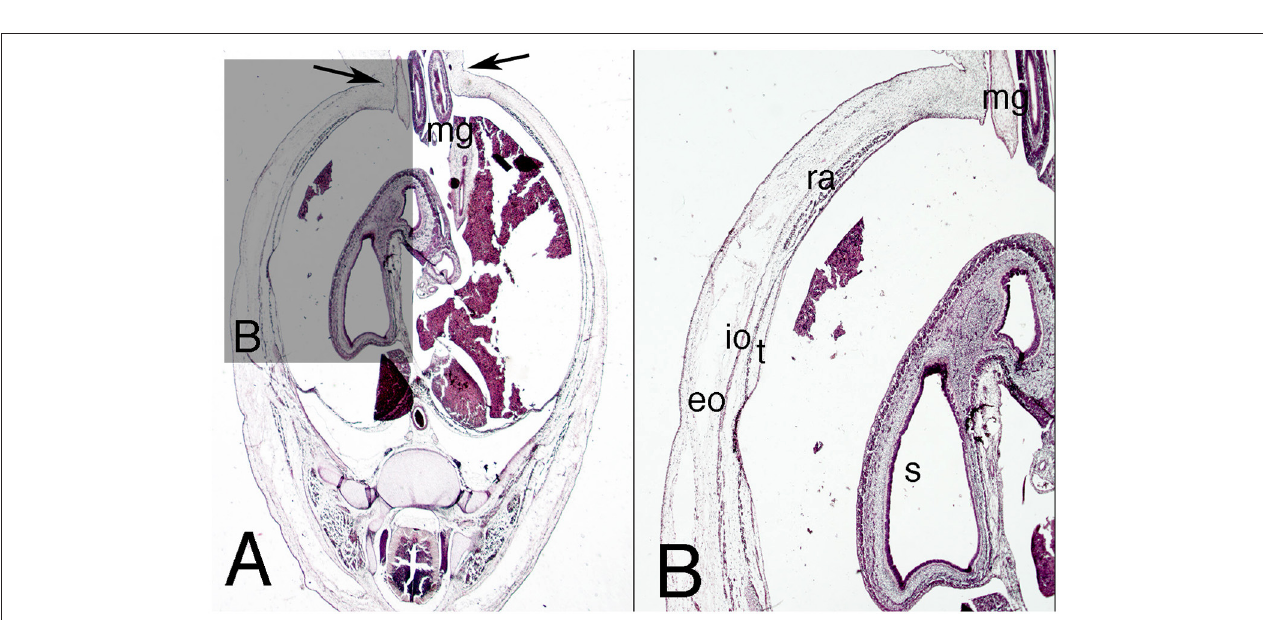
FIGURE 6 | Cross sections of the abdominal cavity of the embryo MARC-1 (stage 21). Hematoxylin and eosin staining. (A) (1X) at the level of the umbilical hernia; (B) (2X) detail of muscles of the abdominal wall. eo, external oblique; io, internal oblique; s, stomach; mg, middle gut; ra, rectus abdominis; t, transversus abdominis. Arrows, neck of umbilical